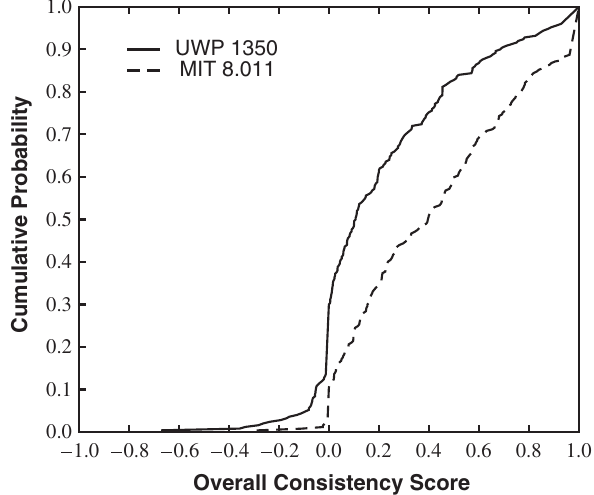
FIG. 2. Cumulative probability distribution of the overall con- defined in Eq. (3)] by subsample. The total sistency score [ C total number of statements used to generate the distributions are 250 for UWP 1350 and 257 for MIT 8.011.